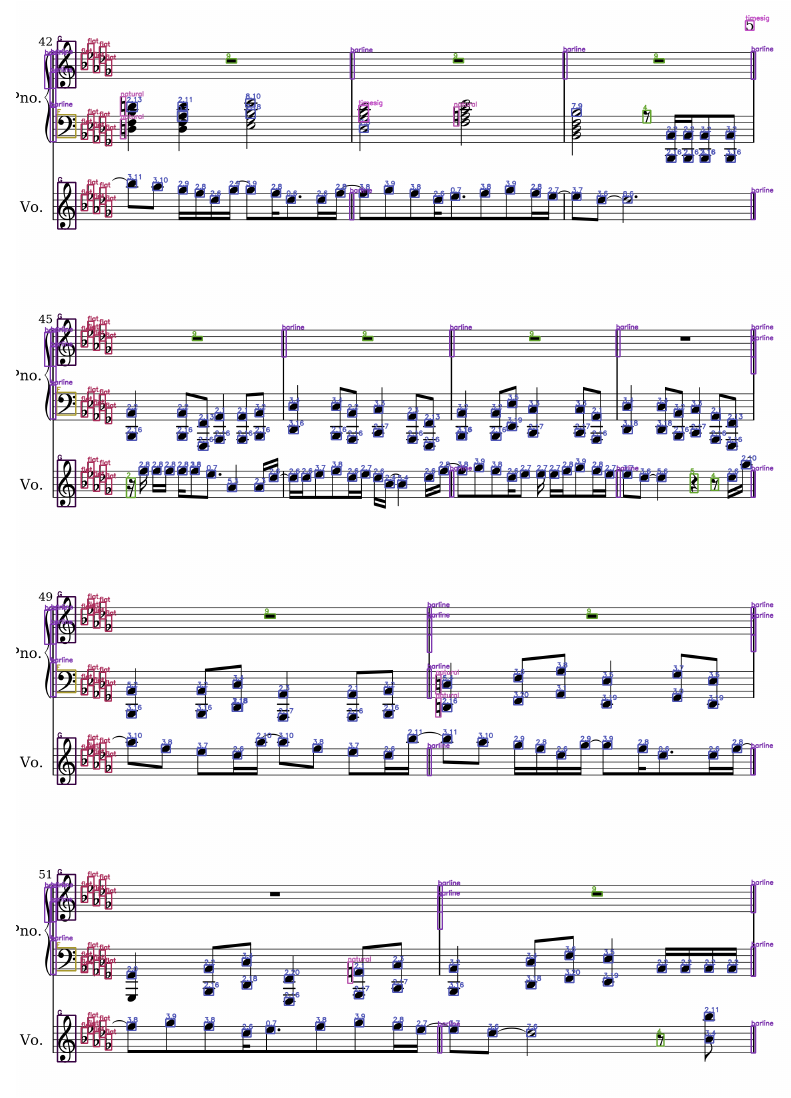
Figure 9. Detection results sample: DeepScores.